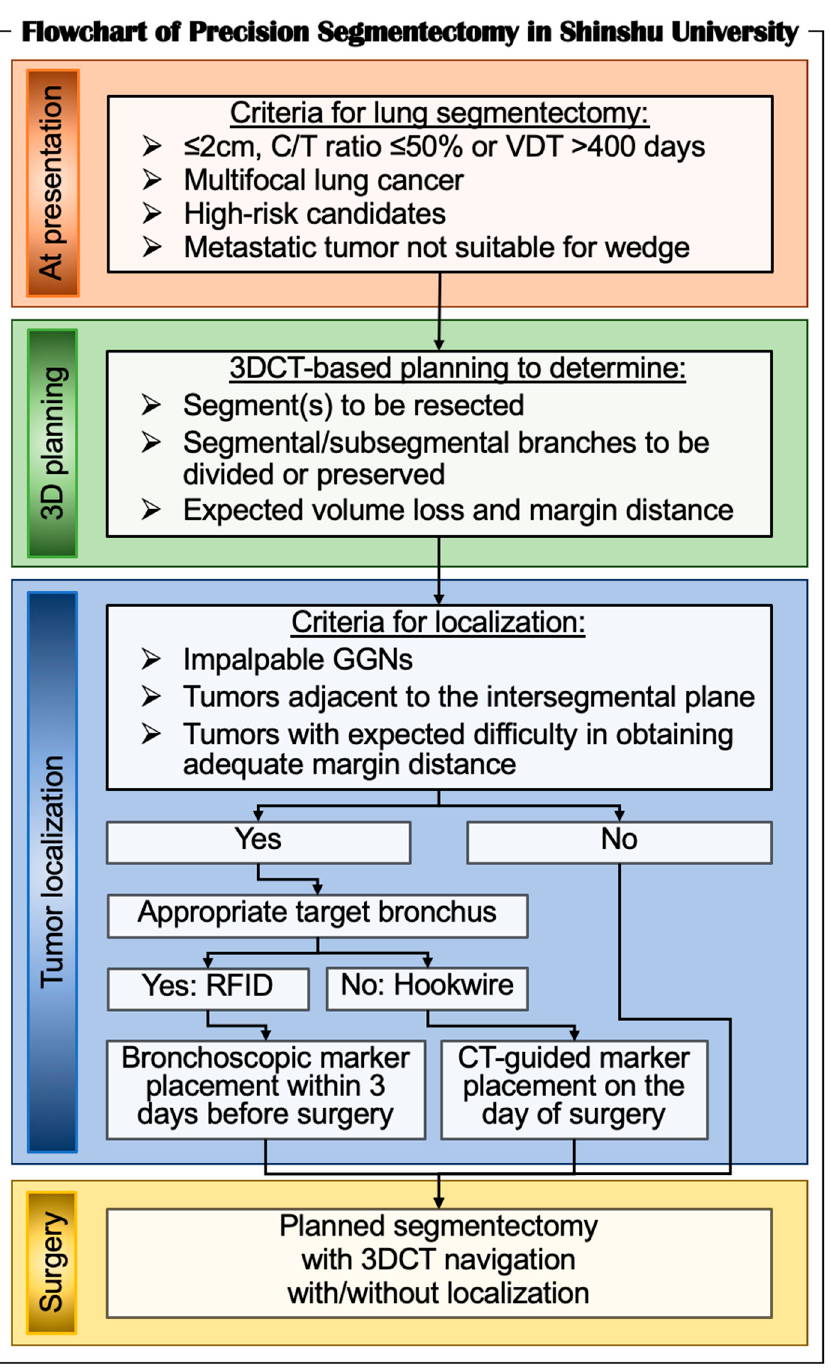
Figure 3. Flowchart of precision segmentectomy in Shinshu University. C/T, consolidation-tumor; RFID, radiofrequency identification; VDT, volume doubling time; 3DCT, three-dimensional computed tomography